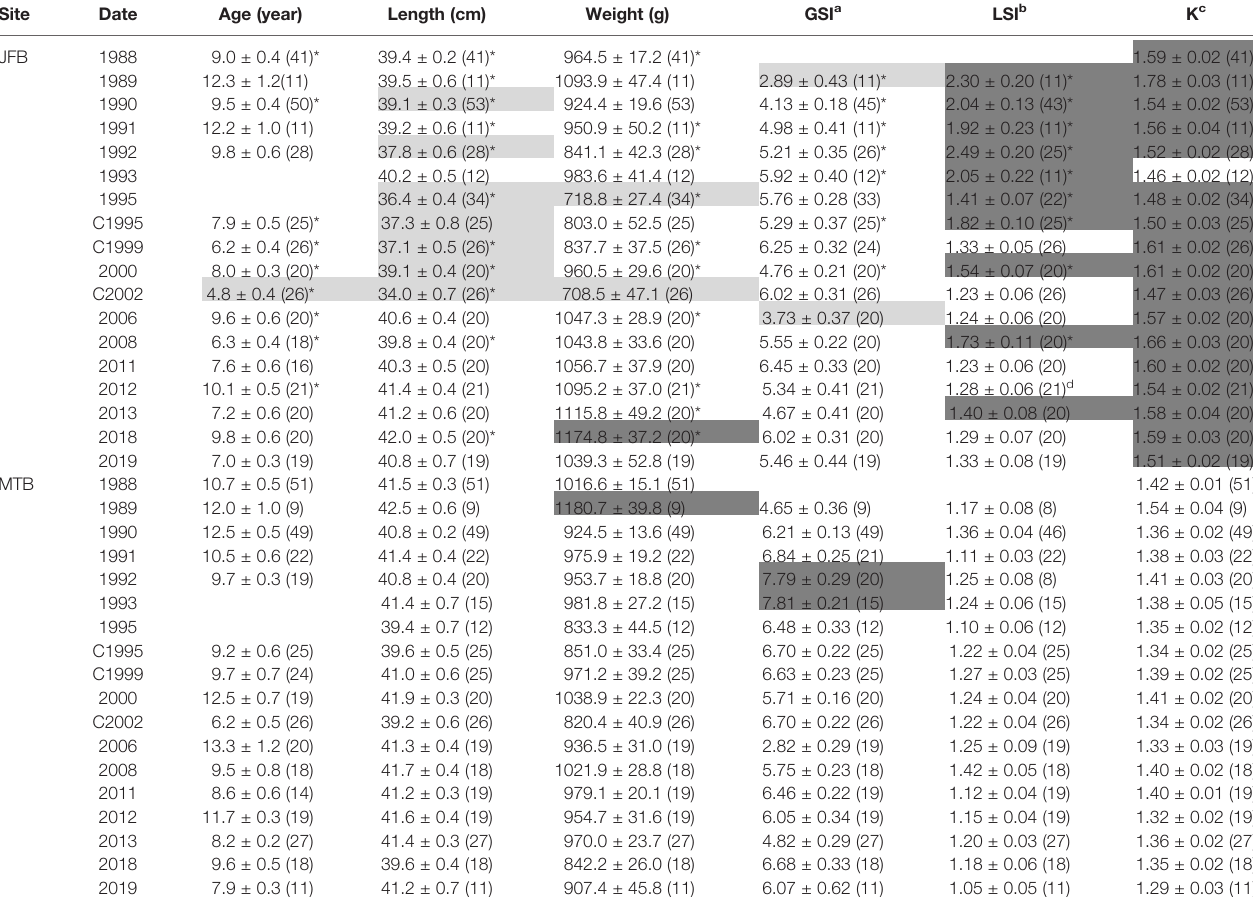
Values are reported as mean ± SE (n). Shaded cells are either below (light grey) or above (dark grey) normal range for Mountain Bay. *Signi fi cantdifferencebetweensites(p ≤ 0.05)withinyears; a GSI=100*(gonadweight/bodyweight); b LSI=100*(liverweight/bodyweight); c K=100×(weight/length3); d Representsan interaction between sites; All data before 2008 published in Bowron et al.